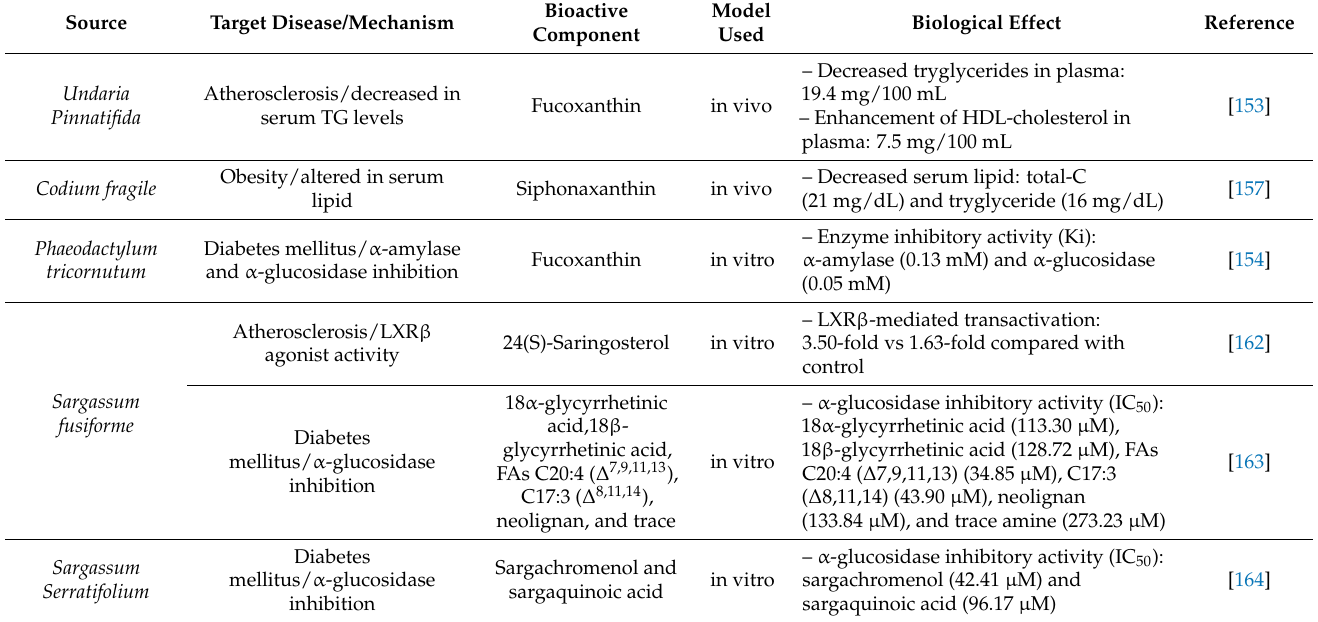
Table 4. Carotenoids and other bioactive substances isolated from seaweeds with therapeutic poten- tial against cardiovascular